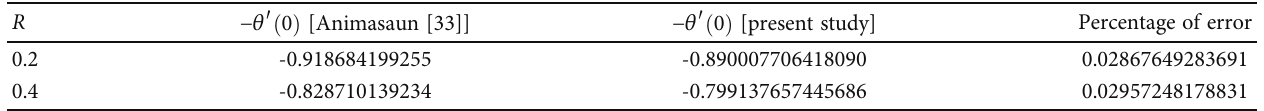
Table 8: Comparison of local heat transfer rate − θ ′ ð 0 Þ for thermal radiation parameter ( R ) applying Classical Runge – Kutta along with shooting technique Animasaun [33] and shooting technique through “ ODE45 MATLAB ”